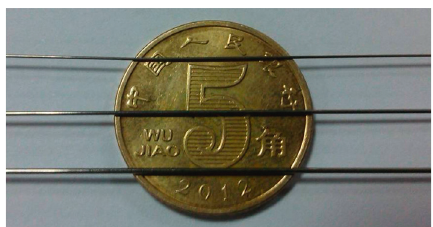
Figure 2: Stainless steel circular microchannels.